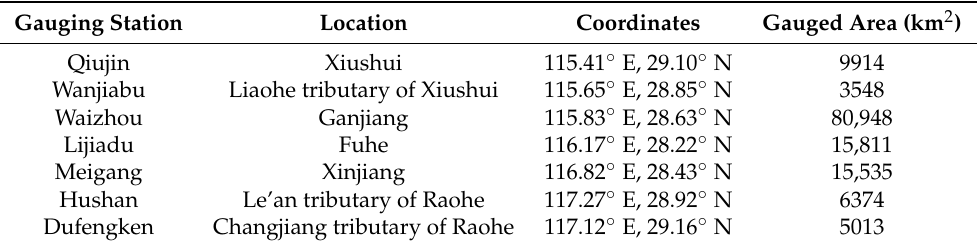
Table 2. List of hydrological gauging stations used in this